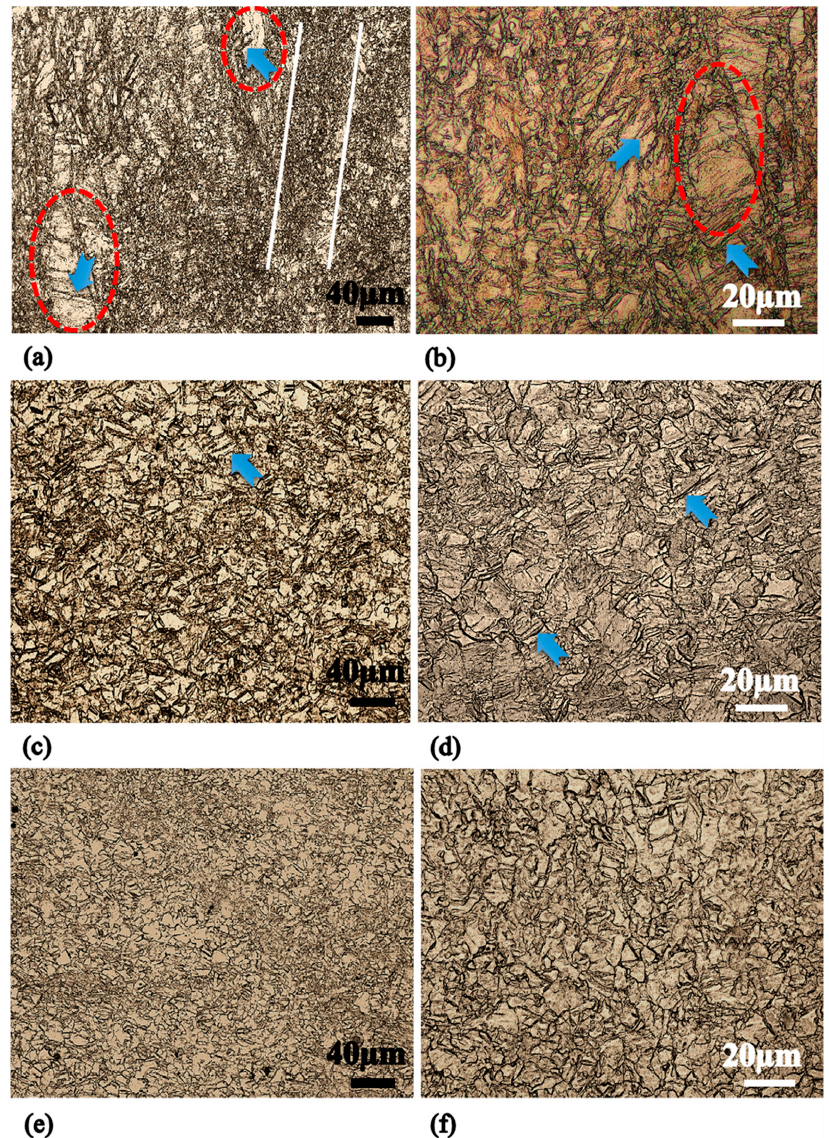
Figure 6. The optical micrographs of rolled sheets using on-line heating at different temperatures: ( a ) 150 °C, ( c ) 200 °C, and ( e ) 250 °C, and ( b , d , f ) are the magnified microstructure corresponding to ( a , c , e ), respectively.